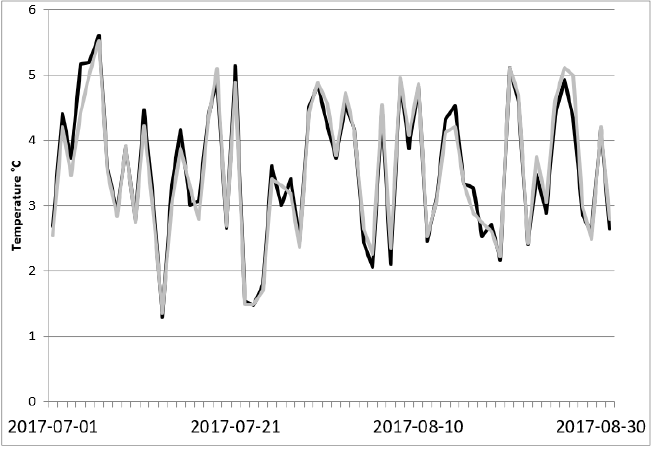
Figure 6. Daily near-surface air temperature standard deviation for control and treatment across all sites for the 2016 summer season [6].